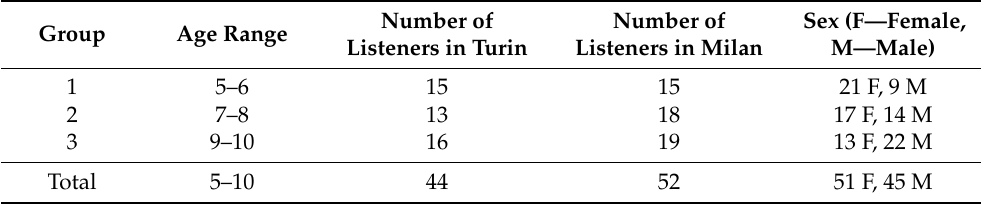
Table 2. Recruited listener sample for the measurements with children.